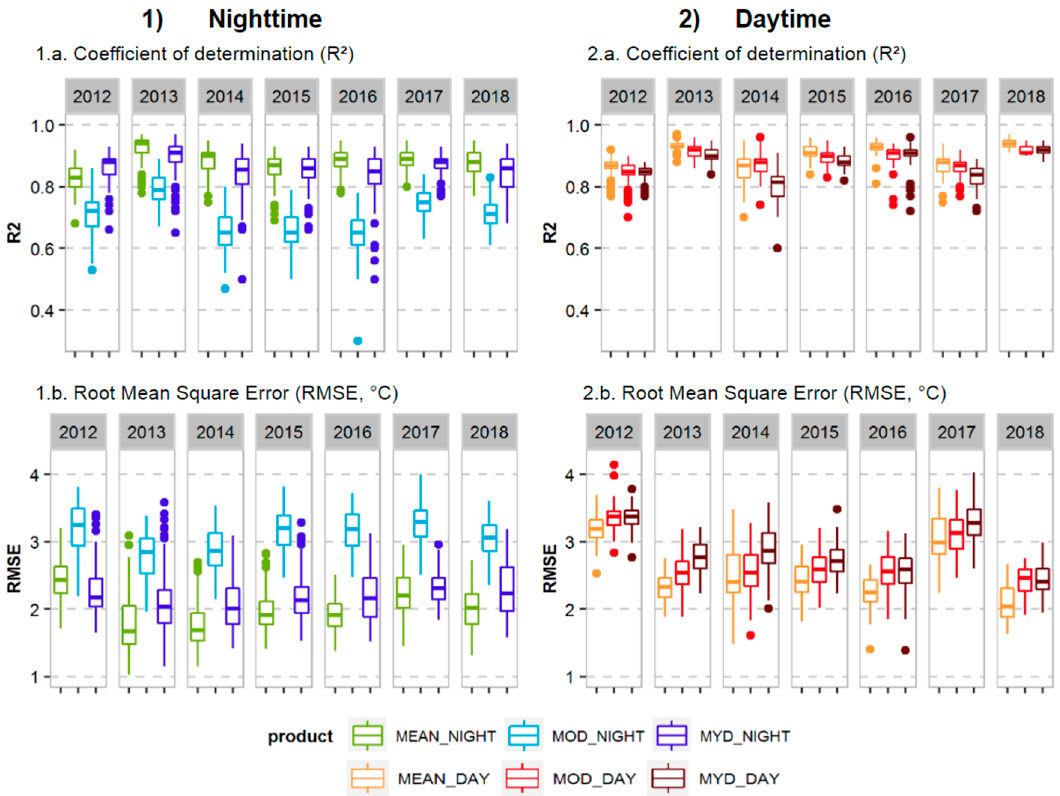
Figure 4. Boxplots of statistical indicators of the linear relationship between daily air temperature and daily land surface temperature (M*D11A1) from 2012–2018 gridded at different spatial resolutions, by the type of MODIS product for each year studied: ( a ) coefficient of determination (R 2 ) and ( b ) root mean square error